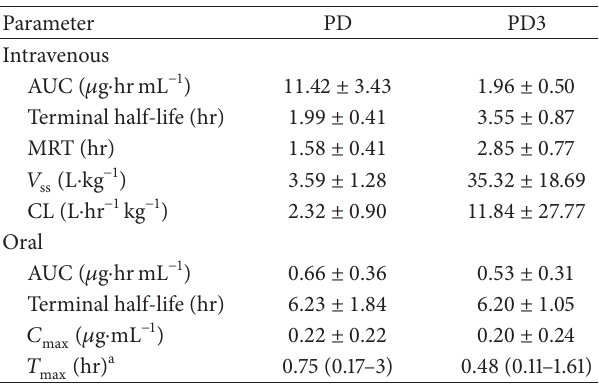
Table 5: Pharmacokinetic parameters of PD and PD3 after intra- venous (25 mg/kg) or oral administration of PD (500 mg/kg) to rats ( 𝑛 = 4 ).